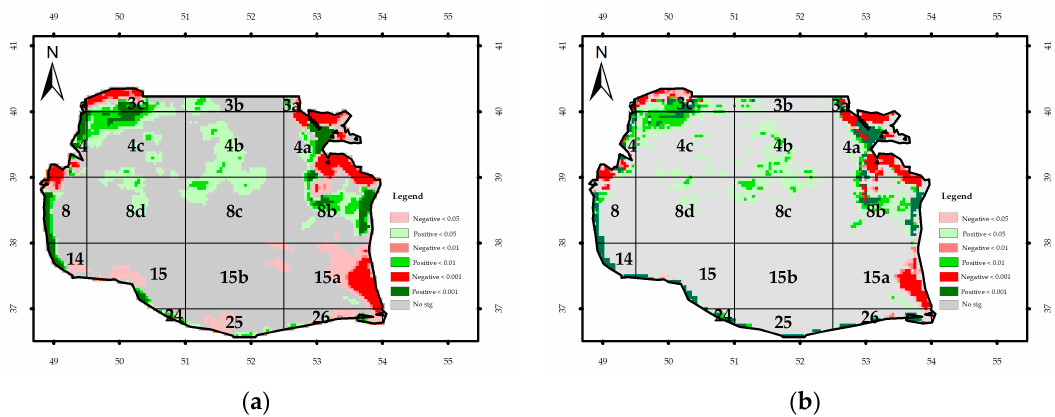
Figure A3. Monthly significance trend of Chl-a concentration in the Southern Caspian Sea (SCS): ( a ) Regional Mann–Kendal and ( b ) Mann–Kendal. Table A1. The significance of bio-optical parameters in the study area. The Mann–Kendall and Regional Mann–Kendal statistics were used and the data are expressed in percentage (%). Significance Level.